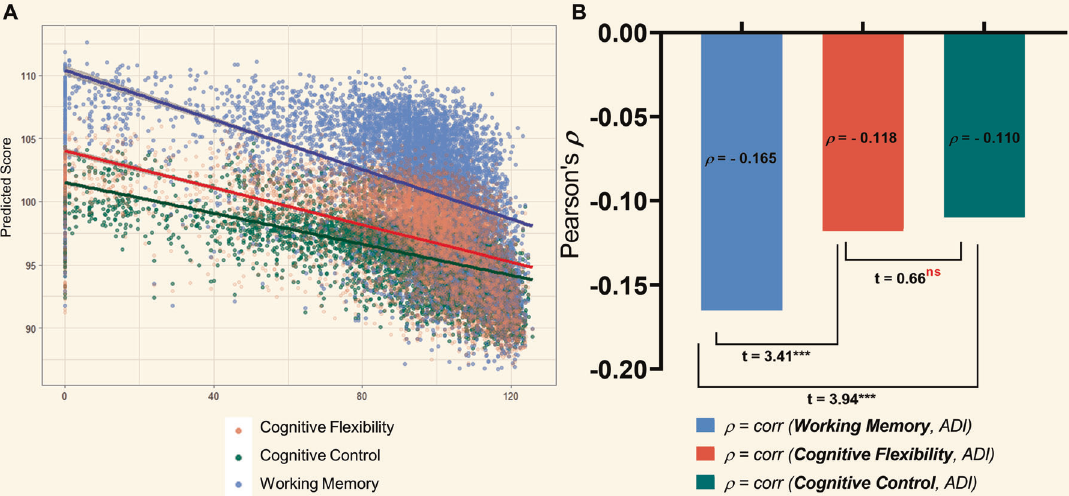
Fig. 2 Neurocognitive subtests of different domains of executive function are differentially associated with ADI. A ADI vs. predicted values on the Flanker (Cognitive Control), Card Sort (Cognitive Flexibility), and List Sort (Working Memory) tasks based on our extended linear regression models as described in Fig. 1. B Statistic comparison of correlation coef fi cients. Bars indicate magnitude of Pearson ’ s correlation coef fi cient ( ρ ) for ADI and each subtest. Fisher ’ s R-to-Z transformation was used to generate a t-test statistic for the difference between each pair of correlations. The correlation between ADI and Working Memory (List Sort Task) was signi fi cantly greater in magnitude than the correlations with the other two tasks. Cognitive Flexibility (Card Sort) and Cognitive Control (Flanker Task) correlations with ADI were not signi fi cantly different from one